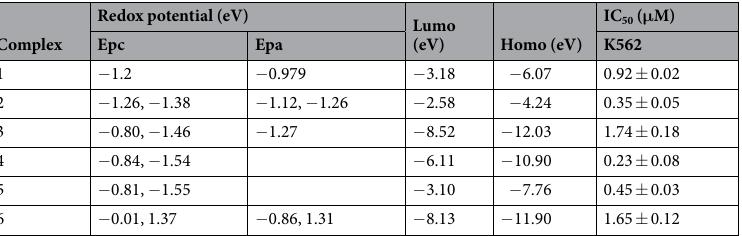
Table 3. Electrochemical potentials, LUMO/HOMO energies, and cytotoxicity of the gold complex 1 – 6 .